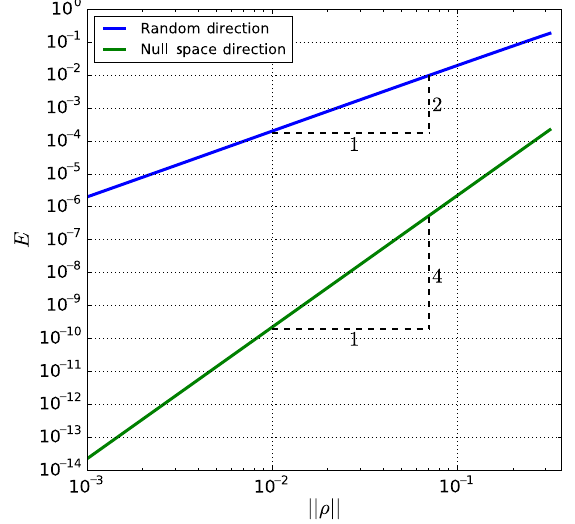
FIG. 7. Stretching energy scaling in a 4-vertex E ð ∥ ⃗ ρ ∥ Þ depends on the direction of ⃗ ρ . For random directions, we have E ∼ ρ 2 , while for directions within the linearized null space of the system, E ∼ ρ 4 . Only two special directions (not shown) exist for which E ¼ 0 to all orders in